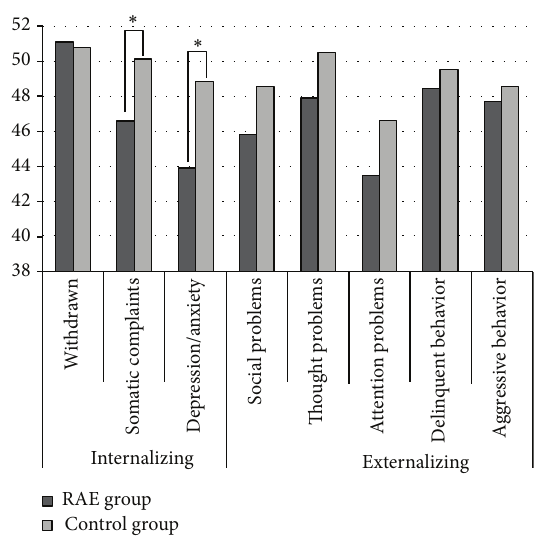
Figure 1: The results of indexes of